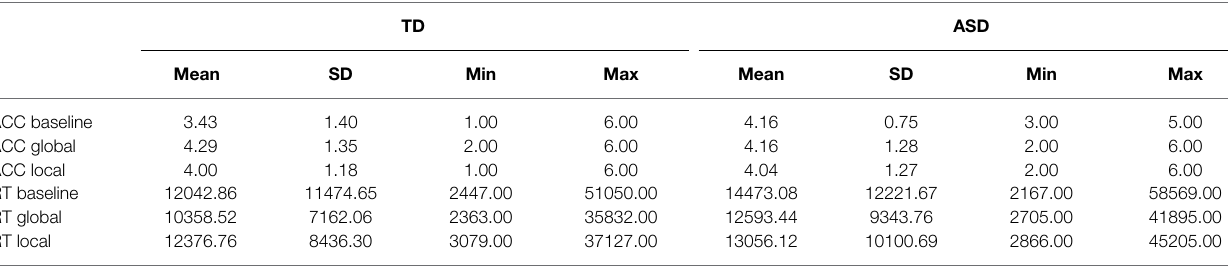
TABLE 2 | Reaction time (ms) and accuracy by participant group.